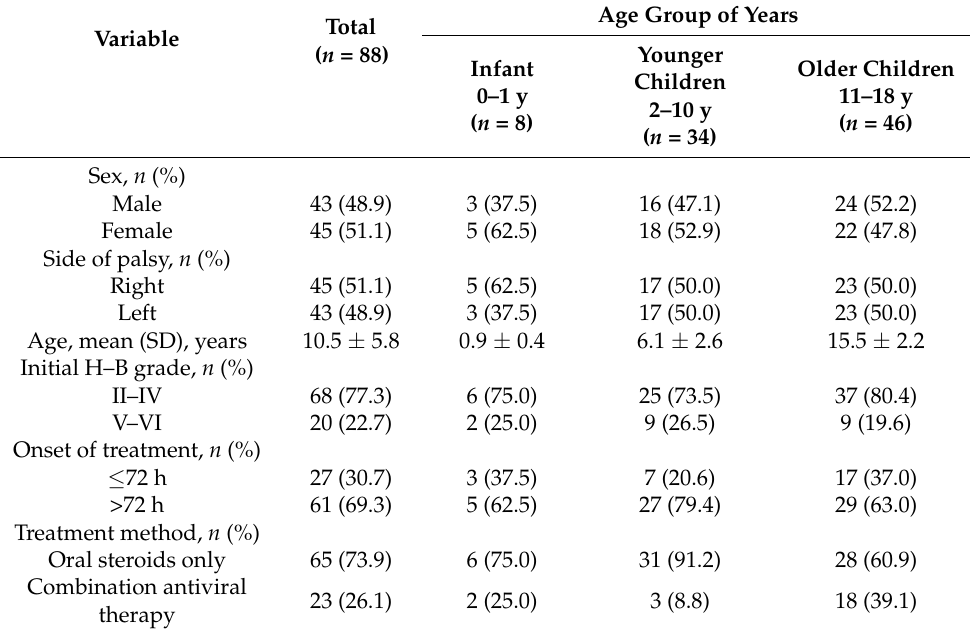
Table 1. Baseline demographic and clinical characteristics and outcomes in the three age groups of children with Bell’s palsy.